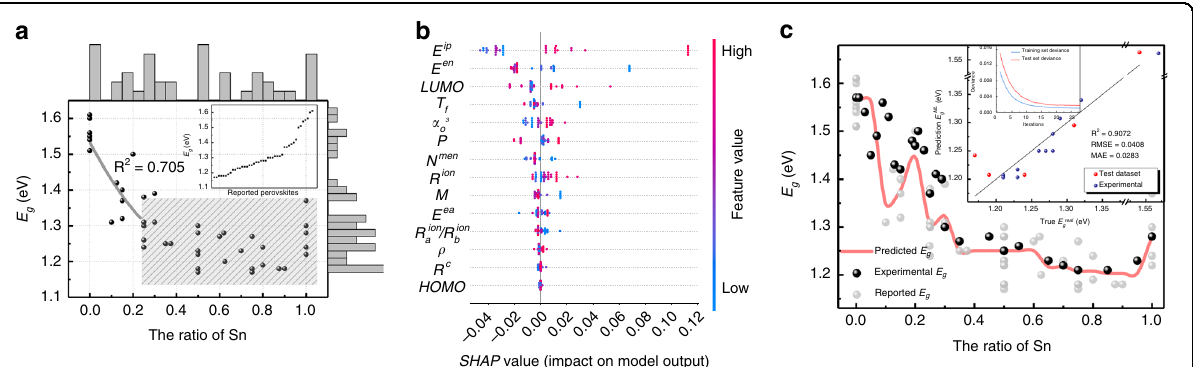
Fig. 2 The results for band gap ( E g ) model. a The marginal histograms and plot of E g versus Sn-Pb ratio. The black dots are collected reported data points, and the gray line is the result of traditional fi tting. The bad fi tting index (0.705) and the disorder shaded part indicates that it is dif fi cult to fi nd the relationship between Sn-Pb ratio and E g by traditional method. The inset is band gap distribution of 43 collected perovskites. b The feature importance ranking produced from GBR and SHAP library with 14 inputs, showing the elemental properties in descending order of importance (rank). The x-axis labeled as the SHAP value represents the impact on E g value. The red and blue color indicate high and low values of a given feature, respectively. The top fi ve features which are most important on the formation of E g are weighted fi rst ionization energy E ip , Mulliken ’ s electronegativity of B-site E en , LUMO, tolerance factor T f and unit cell lattice edge α 3 , respectively. c The comparison of the predicted E g values using o Sn-Pb ratio as input and the experimentally measured values. The light gray dots are collected reported data points for comparison. The inset shows actual values versus predicted results by GBR model for test set and our experimental samples marked with red and blue dots, respectively. The black line represents the ideal situation of the prediction (predicted results are equal to actual values). The smaller the distance between data point and black line, the better and more reliable the prediction. The subplot of inset shows the convergence of model